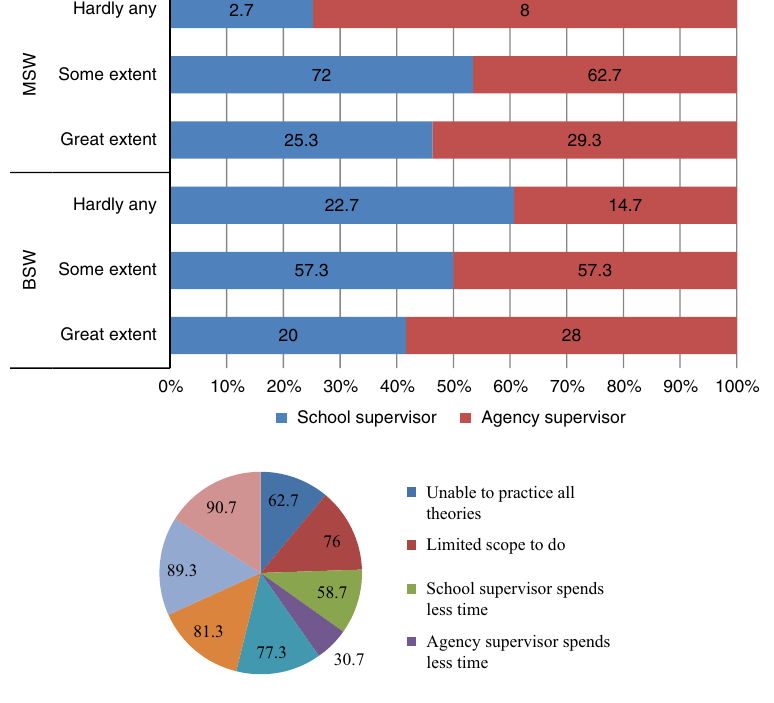
Figure 17. Students ’ perception